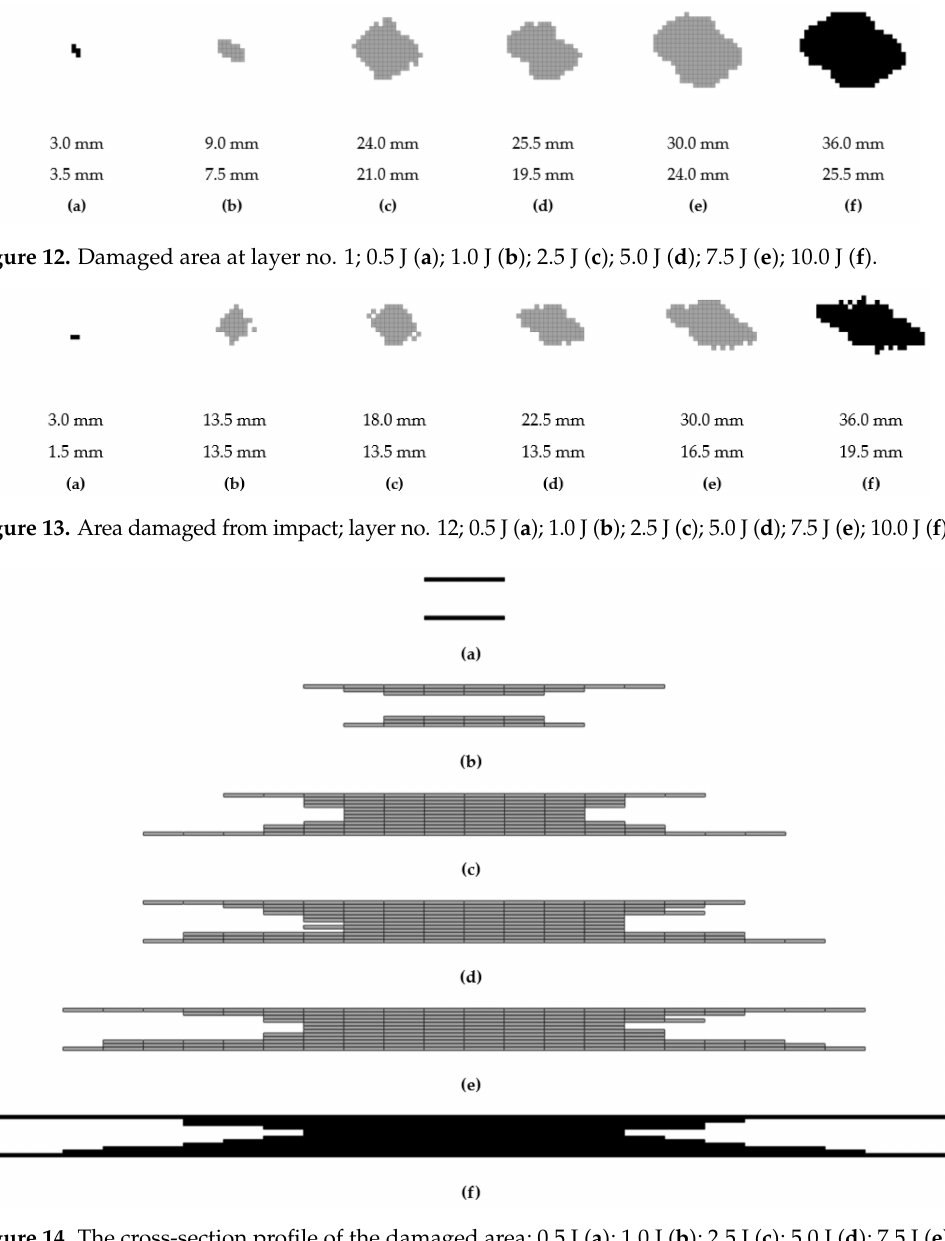
Figure 14. The cross-section profile of the damaged area; 0.5 J ( a ); 1.0 J ( b ); 2.5 J ( c ); 5.0 J ( d ); 7.5 J ( e ); 10.0 J ( f